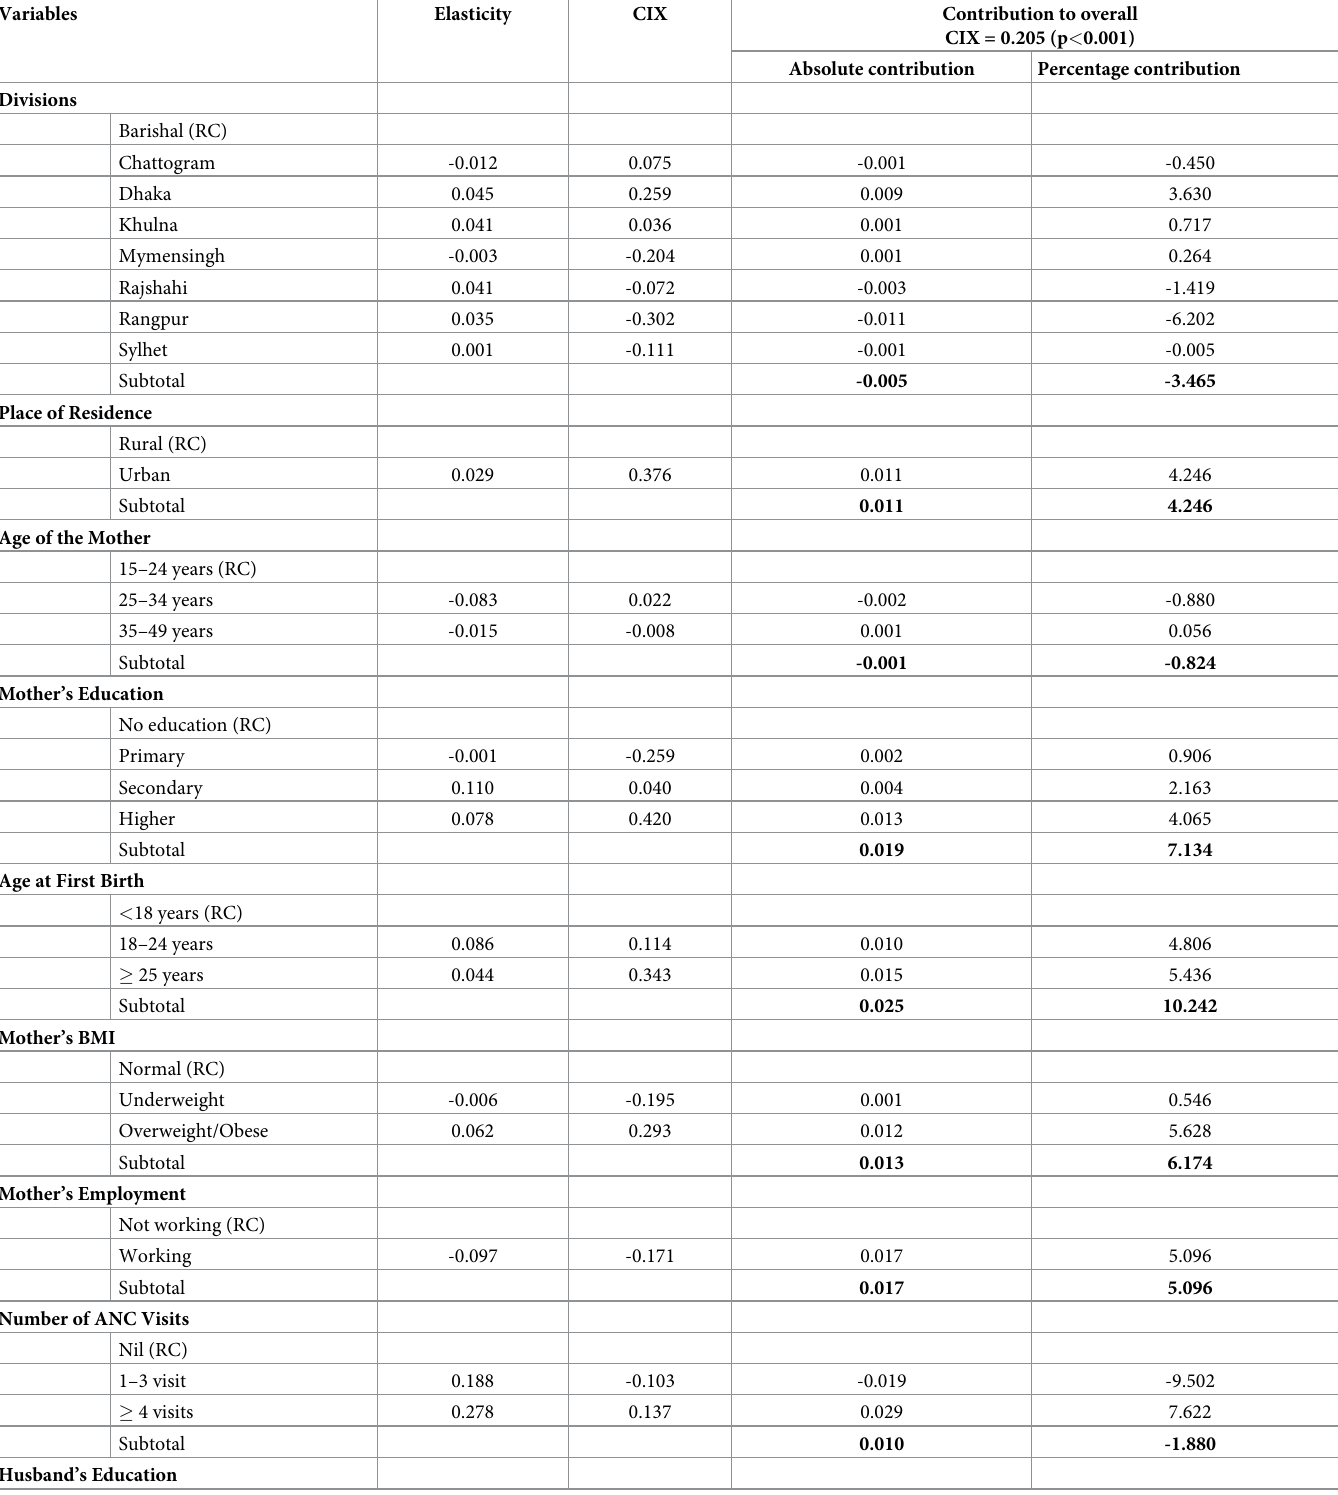
Table 5. Decomposition of concentration index for measuring socioeconomic inequalities in utilizing facility delivery in